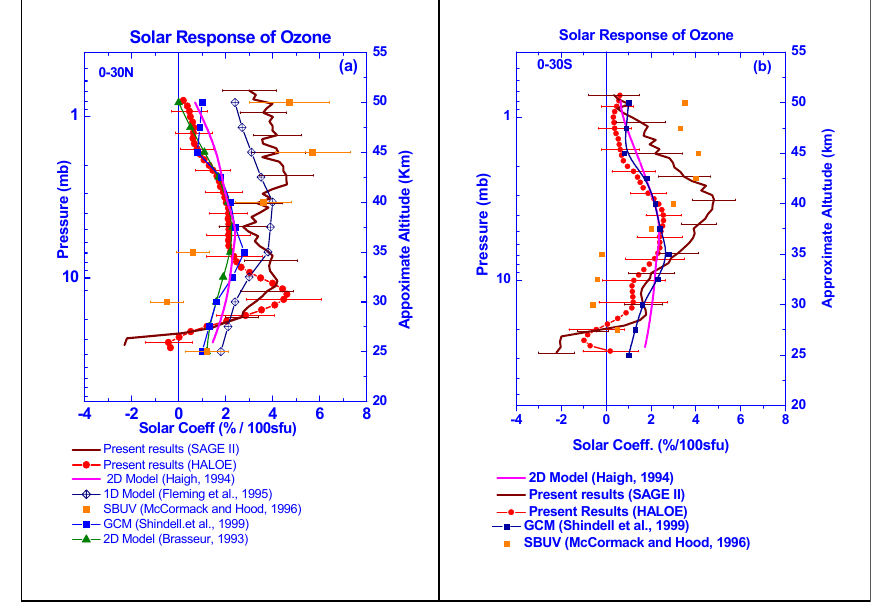
Fig. 2. The vertical distribution of annual mean solar coefficient of ozone (%/100sfu) as obtained in the present study (– HALOE profile) and ( – SAGE II profile) are compared with the results from SBUV data (McCormack and Hood, 1996), indicated by the scatter plot (–), 2-D model (Haigh, 1994) ( -X-), 1-D model (Fleming et al., 1995) (-+), GCM (Shindell et al.,1999) (--), 2-D model (Brasseur, 1993) ( –) over (a) 0–30 ◦ N (b) 0–30 ◦ S latitudinal